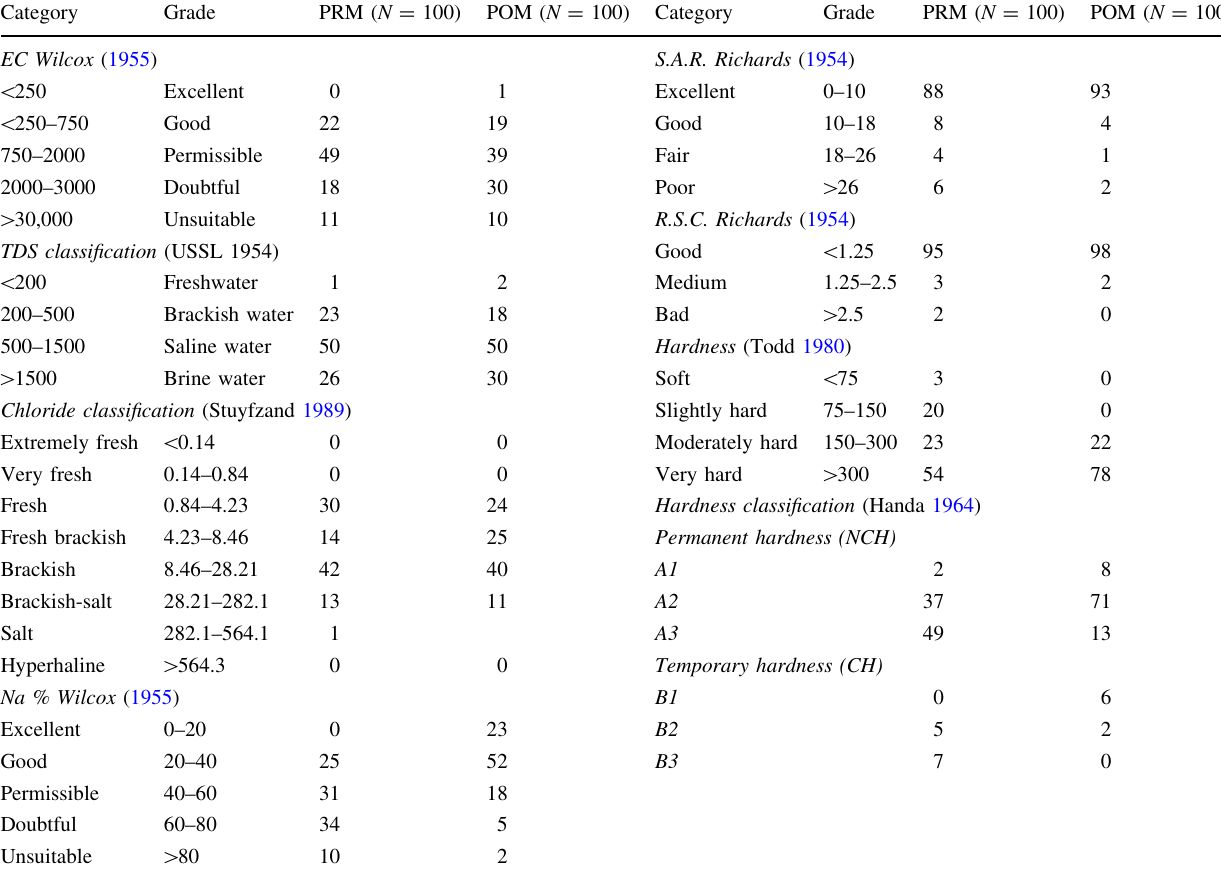
Table 5 Geochemical classification of groundwater samples collected during POM and PRM